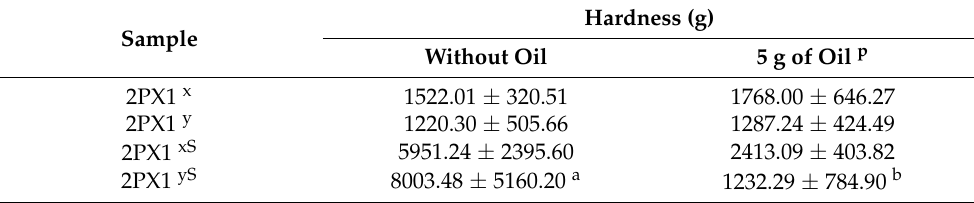
Table 6. Effect of palm oil addition on the hardness of biodegradable spoons containing xanthan.